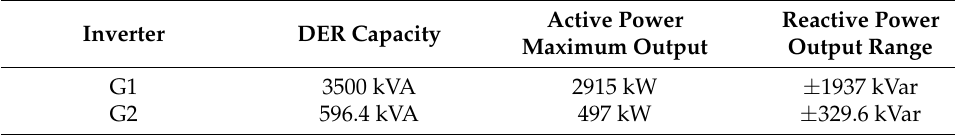
Table 4. Detailed specifications for the smart inverters.